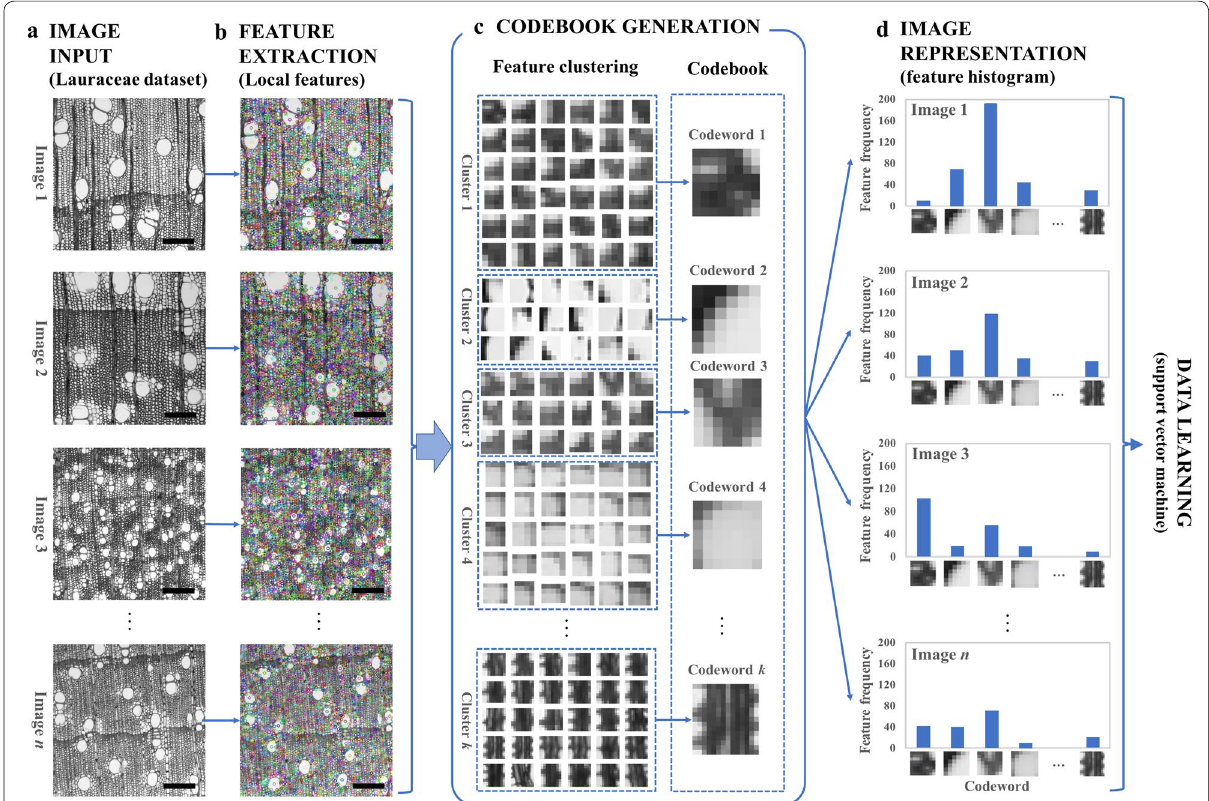
Fig. 1 Process of data learning in the BOF framework. a Input the images of the dataset into the model; b extract local features from the images by SIFT algorithm; c cluster the extracted features and use the center of each cluster as a codeword; and d represent each image by a feature histogram that shows the occurrence frequency of the extracted features. The recognition model learns the histogram of all images. Scale bars 200